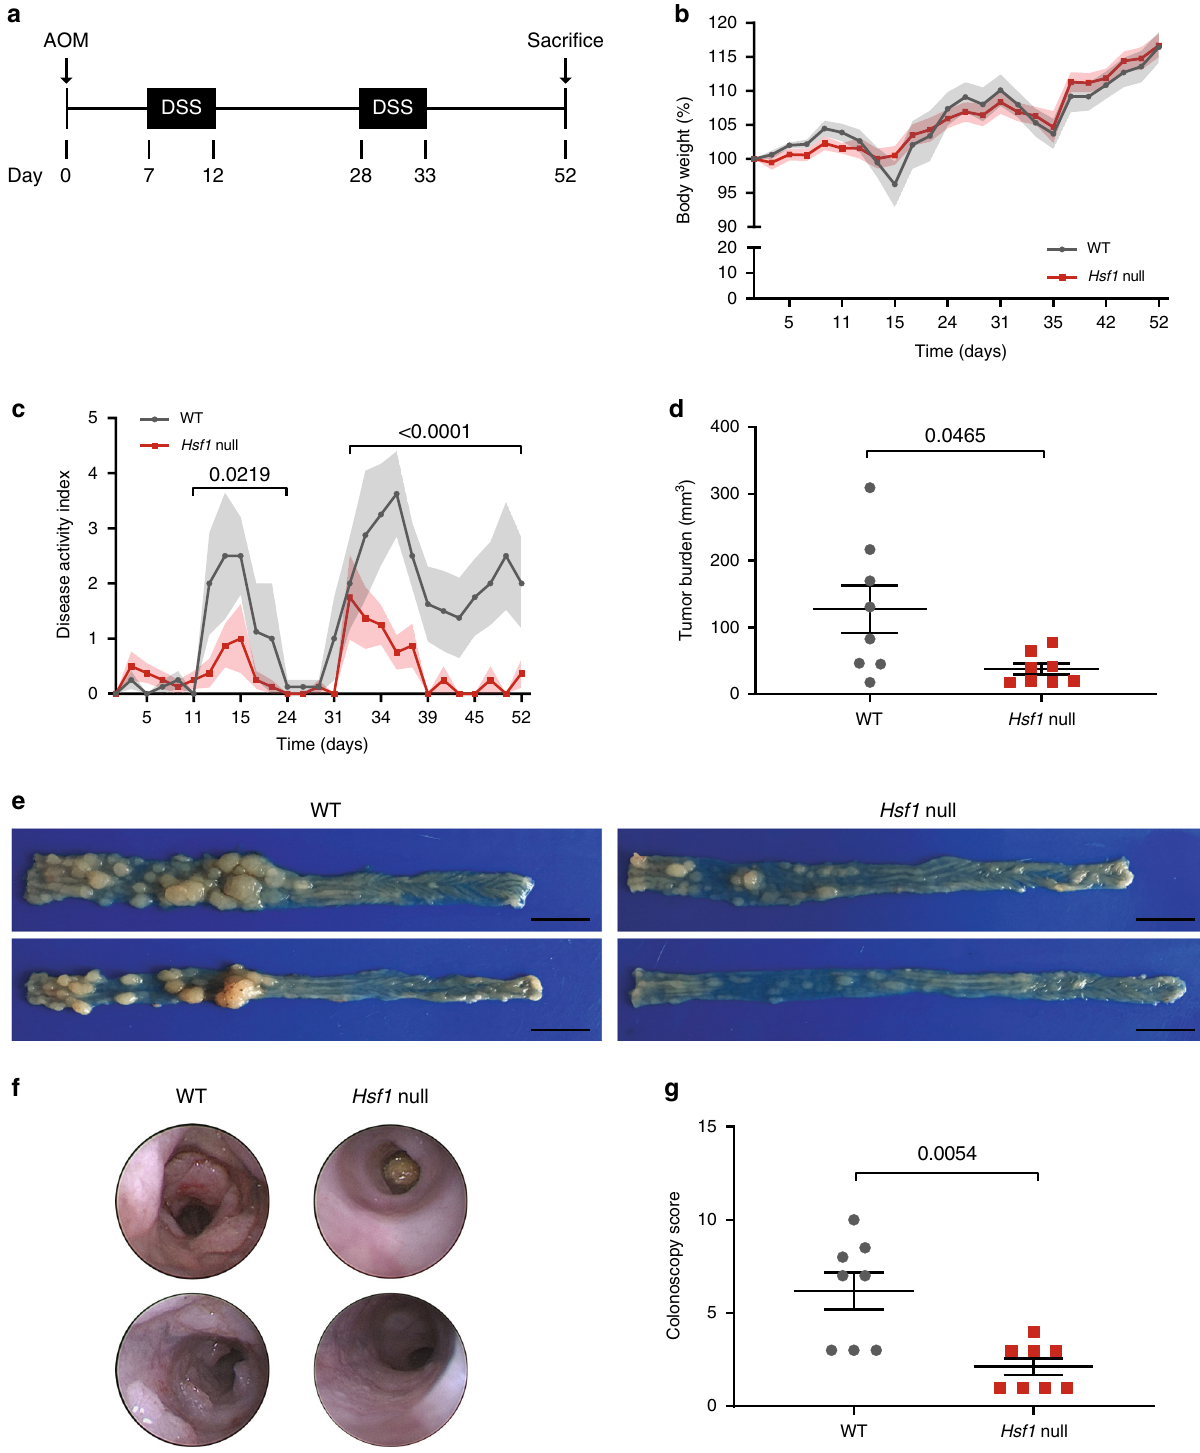
Fig. 2 Hsf1 null mice are highly resistant to in fl ammation-induced cancer. a Schematic representation of the experimental protocol. WT and Hsf1 null mice ( n = 8 per group, combined from two independent experiments) were injected intraperitoneally with AOM (10 mg/kg), followed by 2 × 5-day cycles of 1.5% DSS in the drinking water. b The changes in body weight of the mice throughout the experiment, and c assessment of the disease activity index (DAI) are plotted and presented as mean ± SEM, analyzed by two-way ANOVA (with discrete time point and genotype as the independent variables) utilizing Tukey ’ s test to account for multiple comparisons . d , e Tumor burden calculation based on macroscopic measures of tumors at day 52 of the AOM-DSS protocol. Representative images of two WT (left) and two Hsf1 null (right) mouse colons are shown in e . Scale bar — 1 cm. f , g Prior to sacri fi cing the mice at day 52 of the AOM-DSS protocol, colonoscopies were performed and in fl ammation was scored as described in the “ Methods ” section. Representative images from 2 WT and 2 Hsf1 null mice are shown in f . Colonoscopy scores are shown in g . Results for d , g are shown as mean ± SEM, p value was analyzed using a two-sided Welch ’ s test for d and by a nonparametric Mann – Whitney test for g